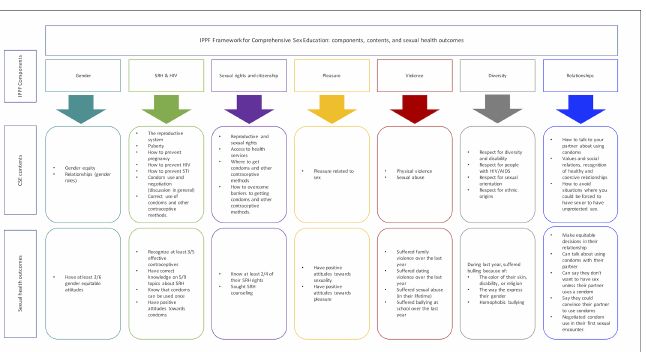
Fig 1. Conceptual framweork of the association between the IPPF framework, CSE components and sexual health outcomes.